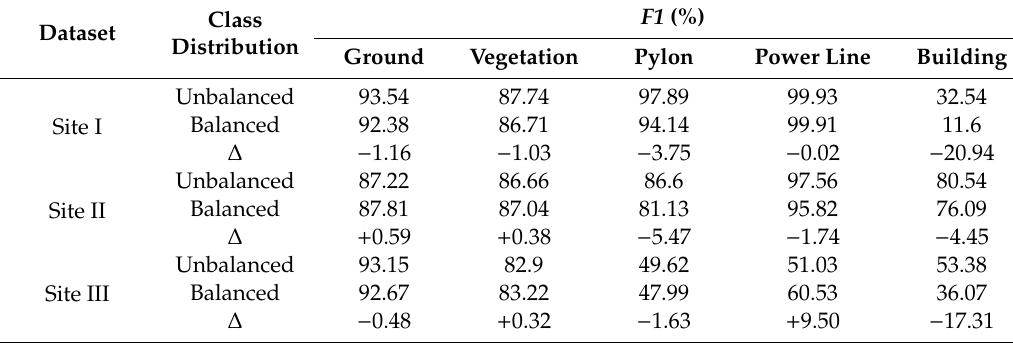
Table 11. Variation of F1 values for different classes and class distributions (classifier = RF, feature set = F 0 , R = 1.5 m). ∆ denotes the difference between the measures obtained by balanced and unbalanced learning.